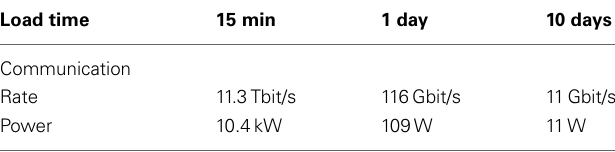
Table 4 | Summary table for loading synapses in a human brain (10 15